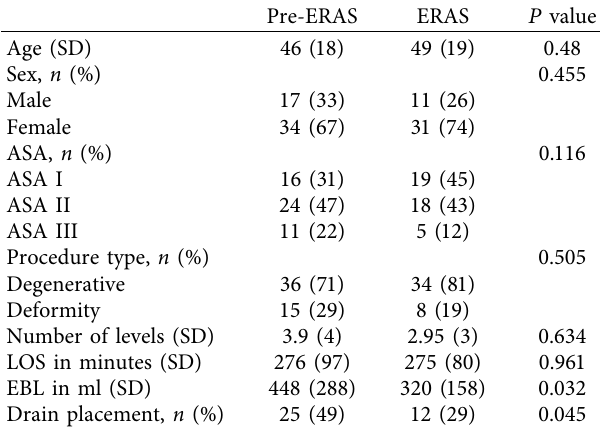
Table 2: Demographic and operative data in both groups with P